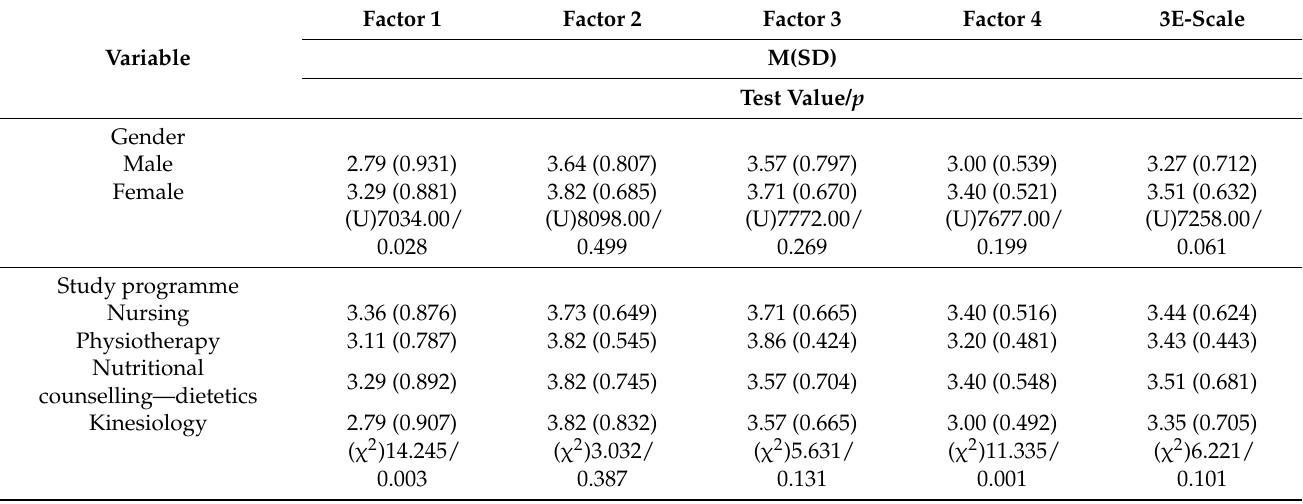
Table 5. Characteristics of the sample population concerning the 3E-Scale and the four